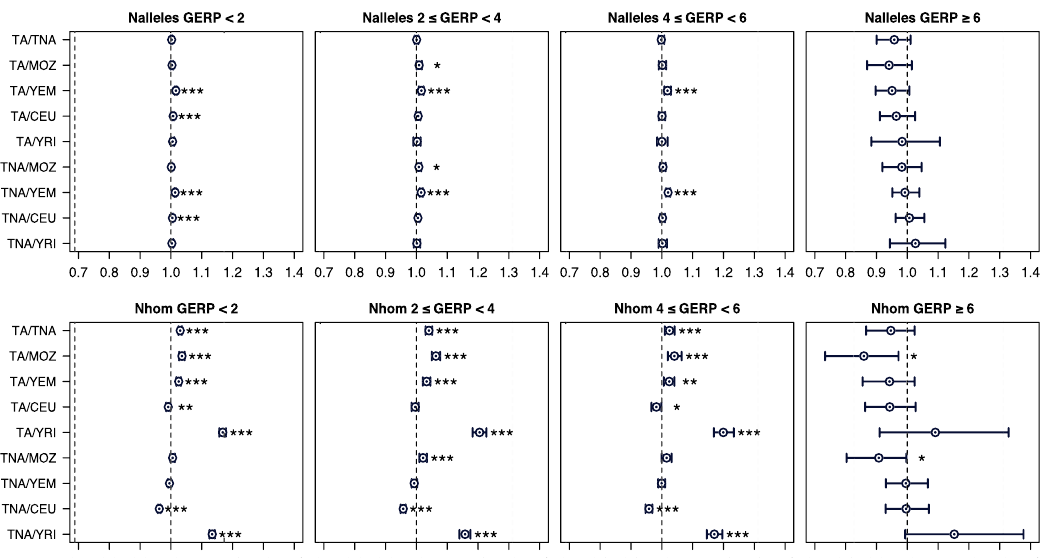
Figure 6. Comparison of the per-individual number of derived alleles (N alleles ) and homozygous derived genotypes (N hom ) across populations for variants in different GERP RS score categories . Pairwise population ratios of the mean per-individual number of derived alleles and homozygous derived genotypes. Plot title indicates the range of GERP RS scores of the variants included. Error bars represent the 0.025 and 0.975 quantiles obtained by bootstrapping by site 1000 times, dividing the exome data into 1000 blocks and performing bootstrap resampling of blocks 1000 times. Statistical significance is shown in the following way: * p < 0.05, ** p < 0.01, *** p < 0.001. To account for multiple testing errors, significance threshold was set to p < 0.001. Population names abbreviated as in Fig.